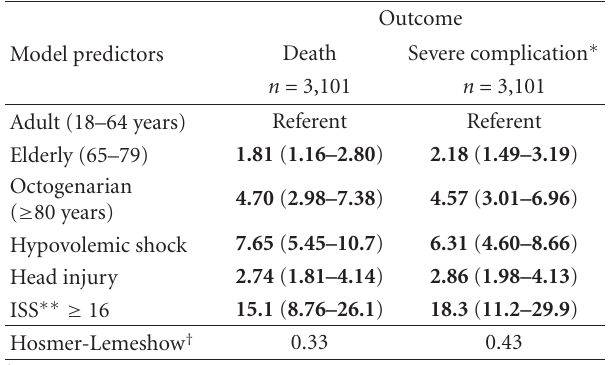
Table 5: Multivariate logistic regression analysis for the population with isolated, closed, and severe pelvic fractures (AIS ≥ 3) using predictors upon arrival to the emergency department with the outcomes death and severe complication (odds ratios and 95% confidence